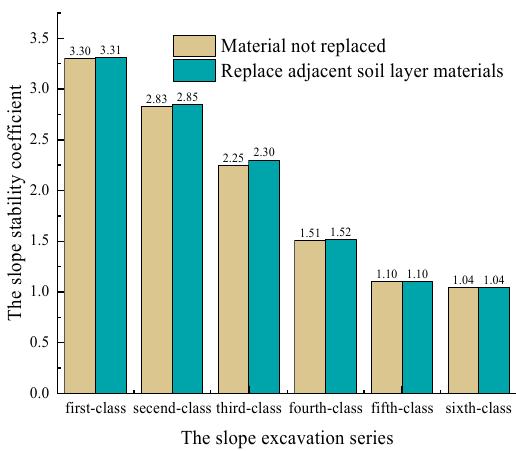
Figure 7. Comparison of the No.1 collapsed roadway.